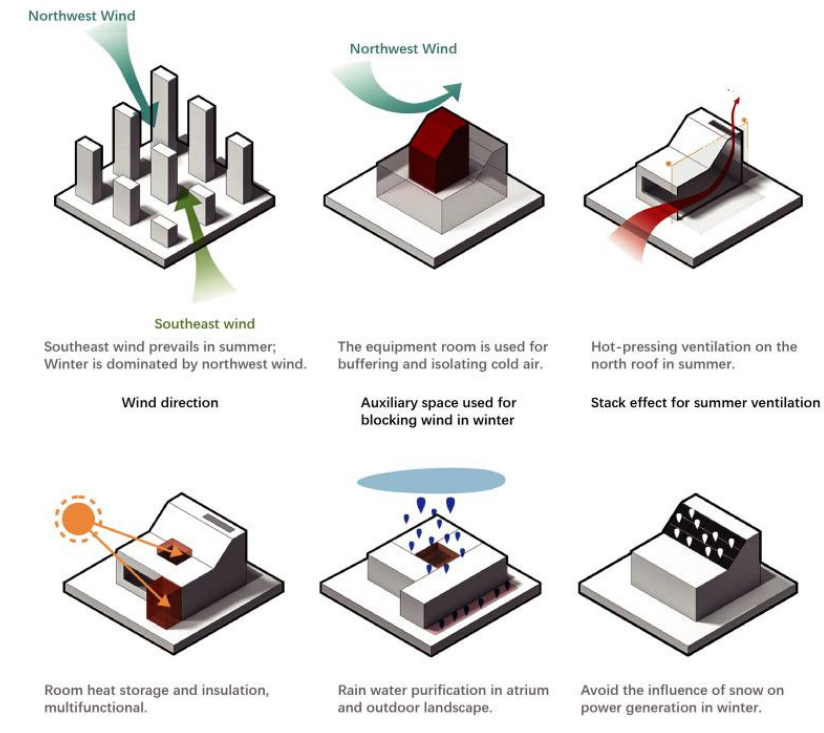
Figure 9. Influence of climatic characteristics on shape design.